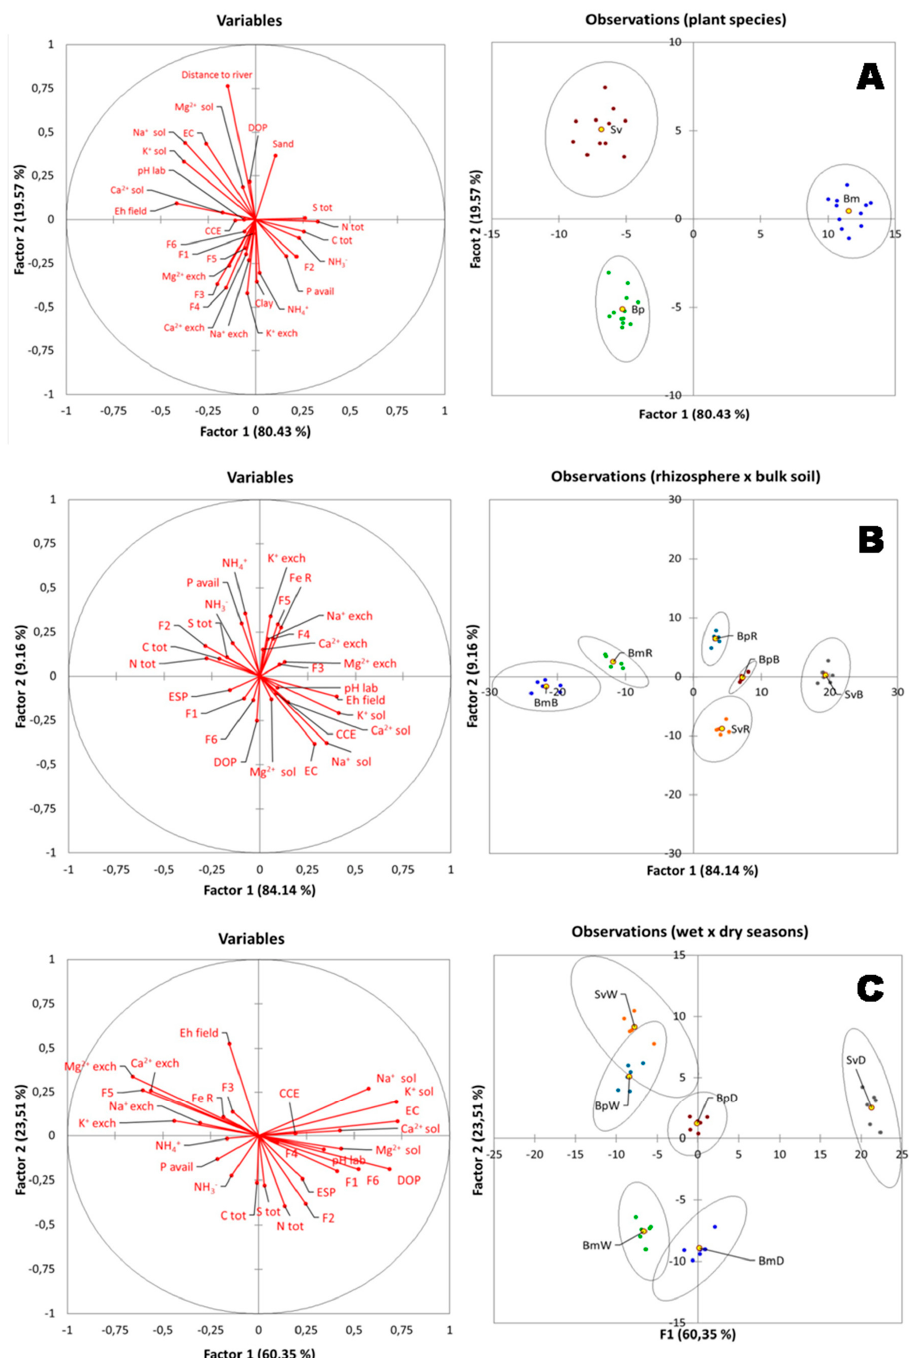
Figure 6. ( A ) Discriminant analysis (DA) of plant species distribution and soil properties in the hypersaline tidal flat (HTF). ( B ) Discriminant analysis (DA) contrasting rhizospheric and bulk soils properties. ( C ) Discriminant analysis (DA) for rhizospheric and bulk soils properties during dry and wet season. Plant species are represented by Bm: Batis maritima ; Bp: Blutaparon portulacoides ; Sv: Sporobolus virginicus . Soil proprieties are Exch.: exchangeable cations (Na + exch; K + exch; Ca 2 + exch; Mg 2 + exch); Sol.: soluble cations (Na + sol; K + sol; Ca 2 + sol; Mg 2 + sol); Tot: total (C tot; N tot; S tot); CEC: cations exchangeable capacity; ESP: exchangeable sodium percentage; EC: electrical conductivity; CCE: Calcium Cabonate Equivalent. Iron (Fe) geochemical fractionation, with the following fractions: F1: Exchangeable Fe; F2: Fe bound to Carbonate; F3: ferrihydrite Fe; F4: lepidocrocite Fe; F5: Crystalline Fe; F6: Pyritic Fe; DOP: Degree of